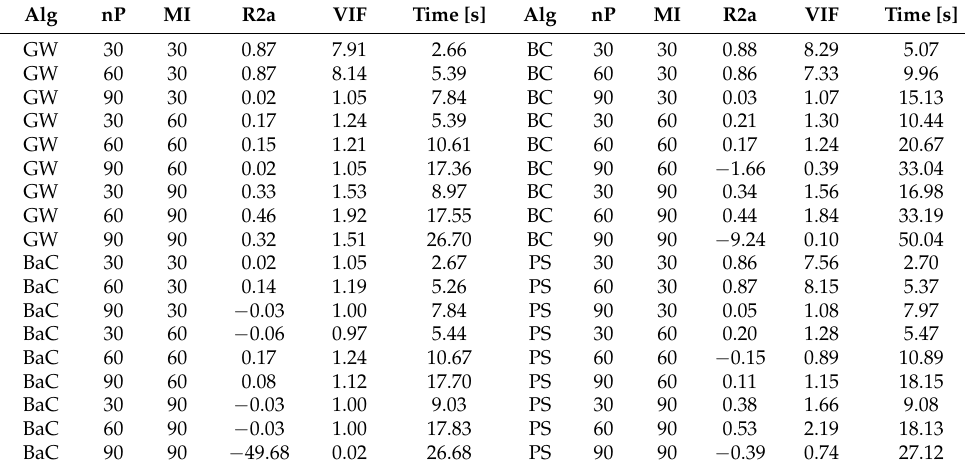
Table 5. Extract of scenario results for a set of algorithms used (nP—population size, MI—maximum iteration number, and R2a—R2 adjusted).